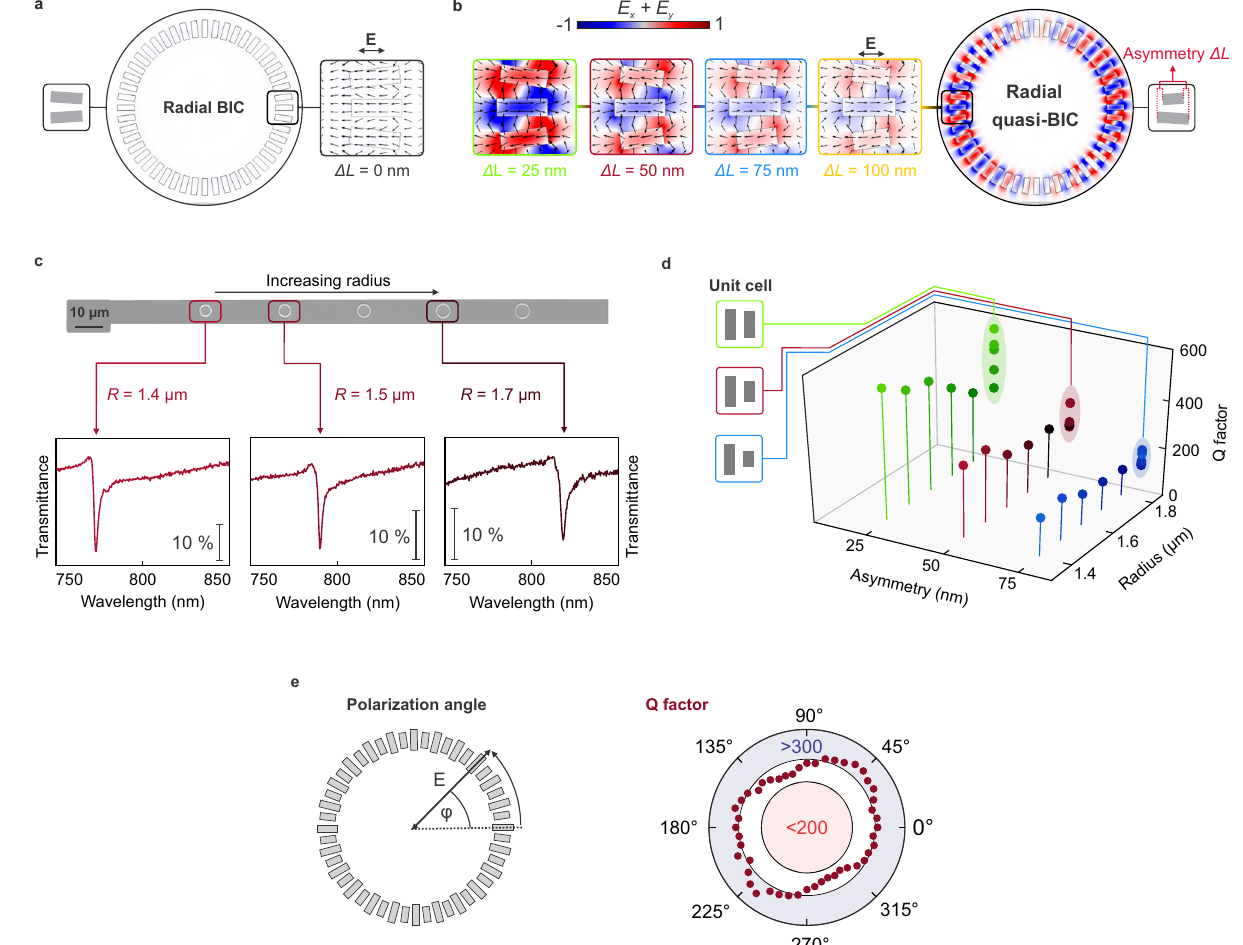
Fig. 2 | Versatile radial BIC resonances and polarization invariance. Electric near fi elds for a symmetric radial BIC ( Δ L = 0 nm) in a and several symmetry- broken radial quasi-BIC ( Δ L >0nm) geometries in b . c Optical transmittance spectra of the radial BIC structures show a resonance redshift with increasing radii, as illustrated in the gray-scale optical micrograph. d Dependence of the